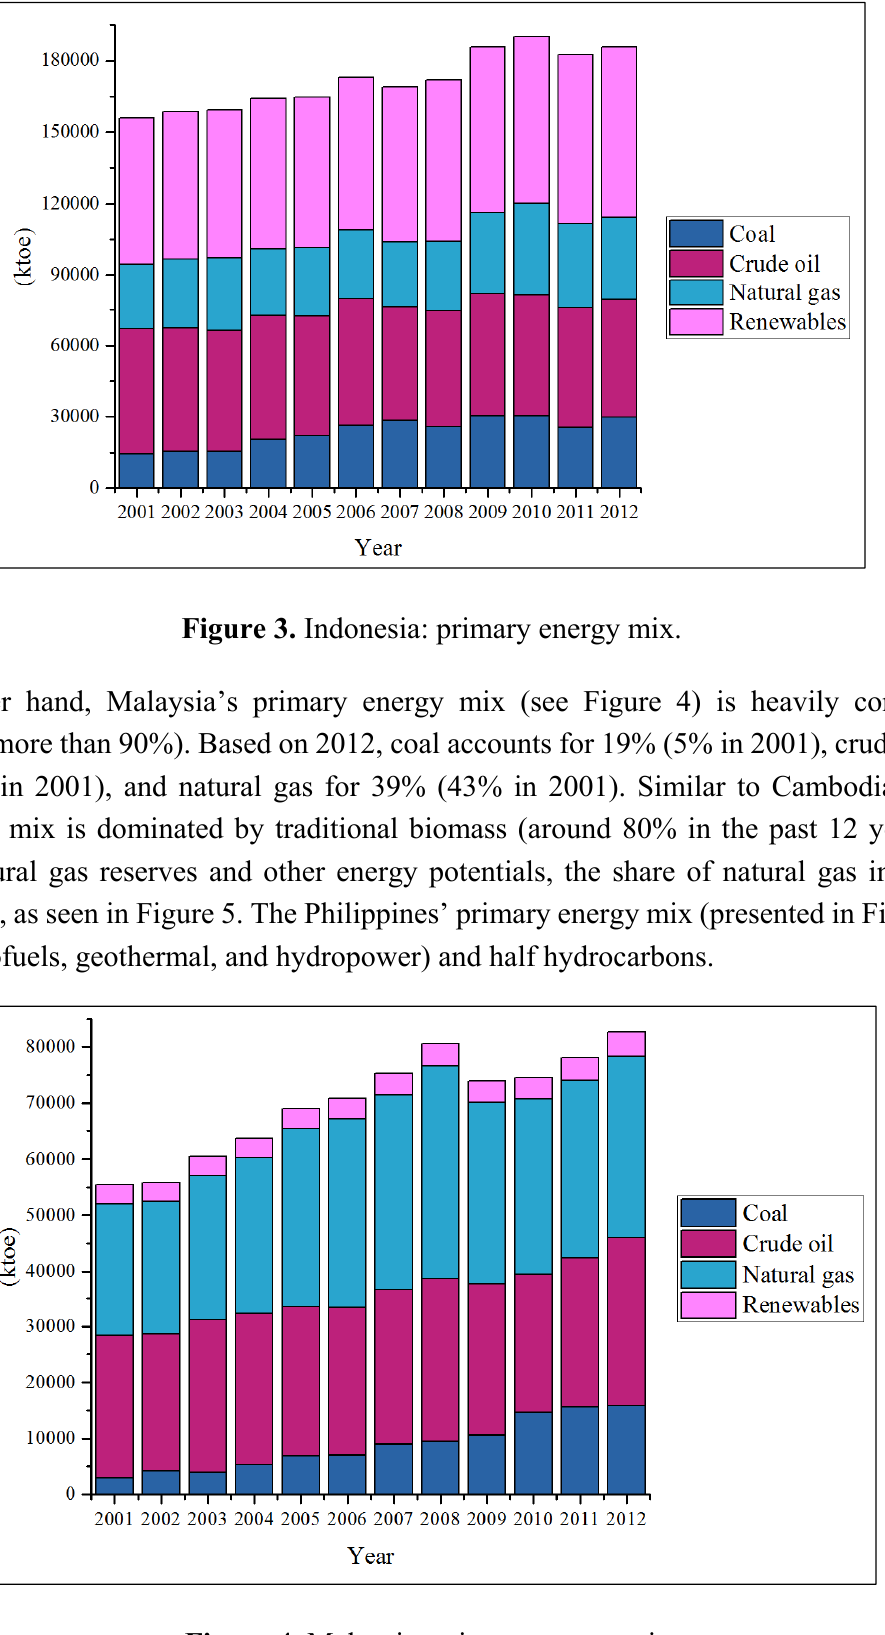
Figure 4. Malaysia: primary energy